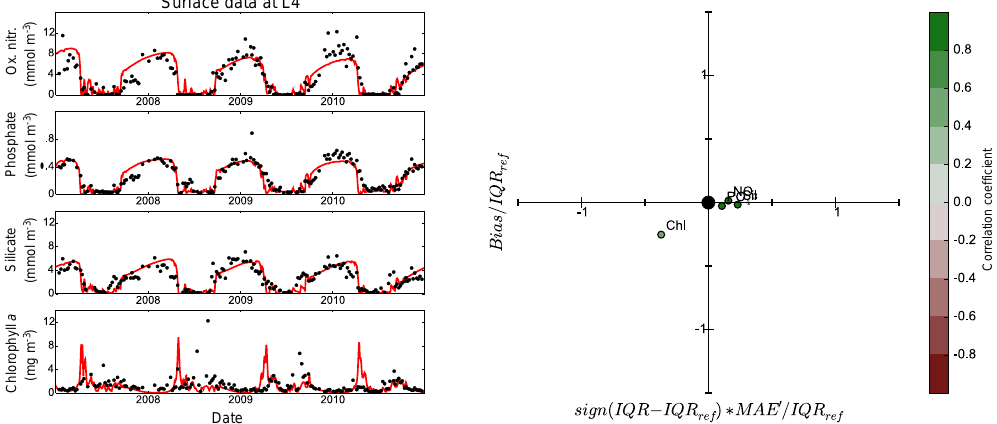
Figure 8. Simulation results vs. in situ data at the L4 site – left panels: model time series (red lines) vs. in situ measurements (black dots) for oxidized nitrogen, phosphate, silicate, and chlorophyll a (top to bottom panels); right panel: target diagram with bias (abscissa), MAE’ (ordinate), and Spearman correlation (colour code) for oxidized nitrogen (NO 3 ), phosphate (PO 4 ), silicate (Sil), and chlorophyll a